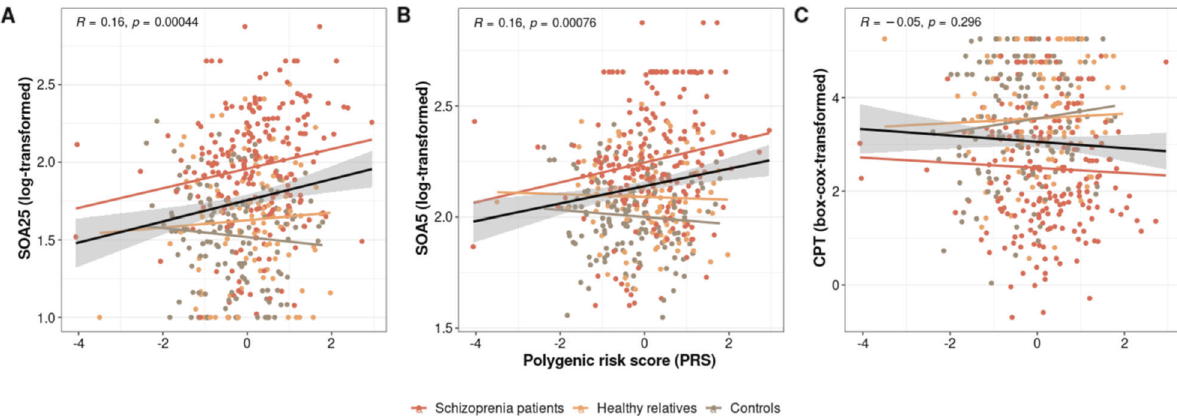
Fig. 8 Polygenic risk score (PRS) versus 25 and 5 elements grating (SOA25 and SOA5), and continuous performance test (CPT). Weighted linear regressions using PRS as a predictor for A SOA25, B SOA5, and C CPT. Separate lines and points for each group are colored according to legend. The black line (with con fi dence interval) represents the overall line of best fi t. Overall Pearson correlation coef fi cient (R) with signi fi cance ( p ) is presented in each